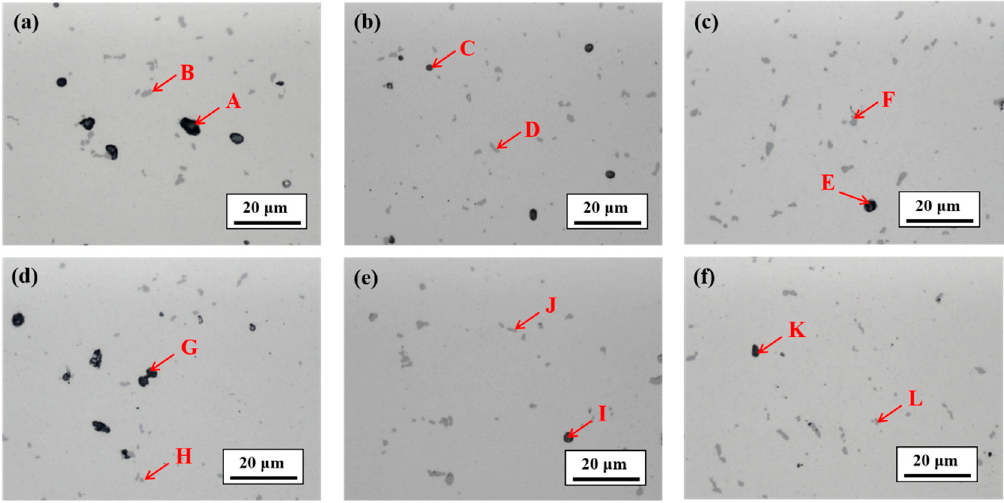
Figure 6. Secondary phase observations of ( a ) RH10; ( b ) RH30; ( c ) RH120; ( d ) IR10; ( e ) IR30; and ( f ) IR120.